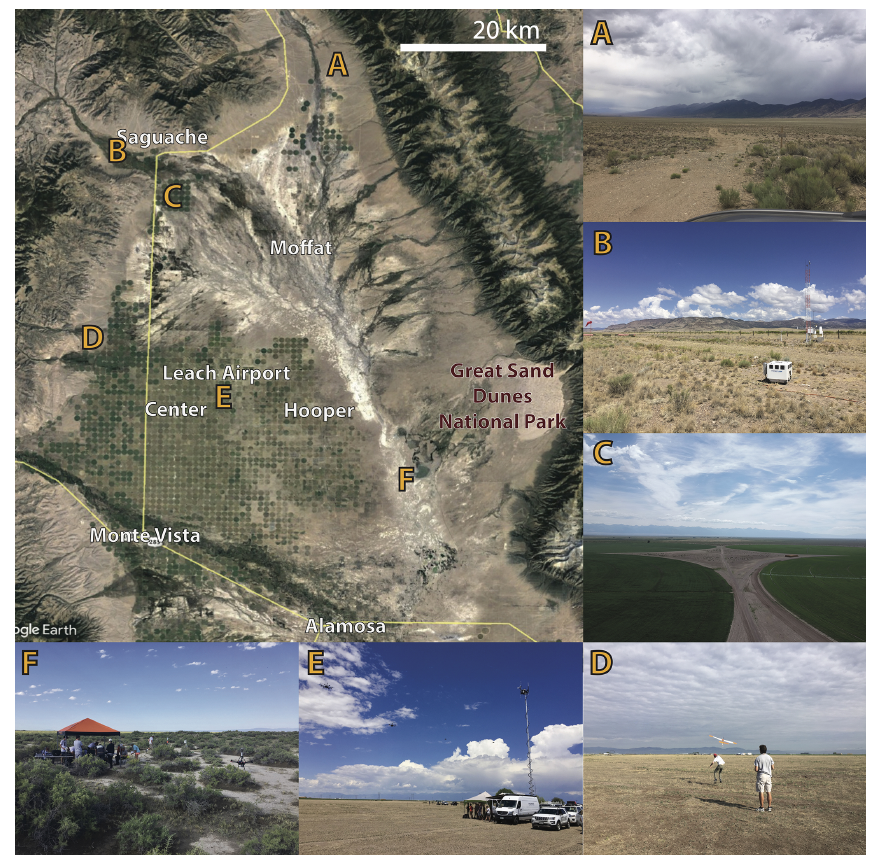
Figure 1. A map of the San Luis Valley of Colorado and photographs providing a perspective on the general variability in surface conditions around the valley. The satellite image in the large map in the upper left is courtesy of © Google